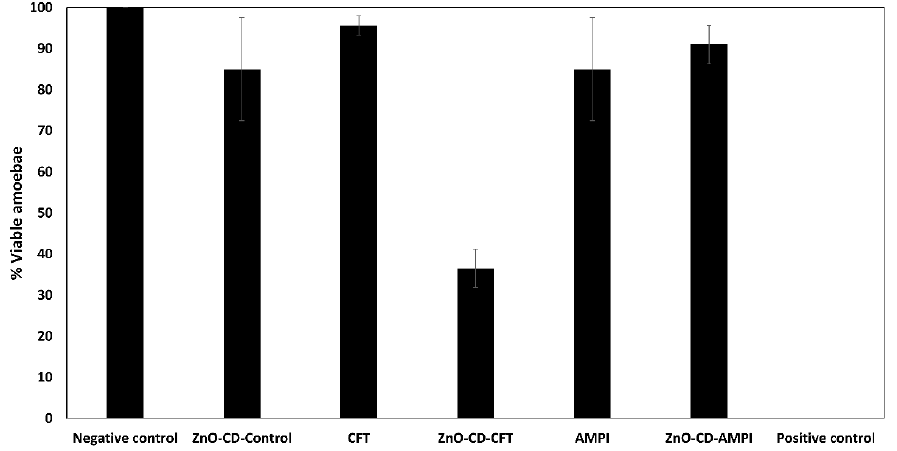
Figure 2. The amoebistatic effects of the compounds were tested. ZnO-CD-CFT markedly inhibited the growth of A. castellanii at a concentration of 100 µ g/mL in 24 h of incubation. The other compounds showed no amoebistatic effects of significance. The results are presented as the mean ± standard error. Note that ZnO-CD-CFT but not CFT alone showed significant inhibition ( p < 0.05, using a two-sample t test, two tailed